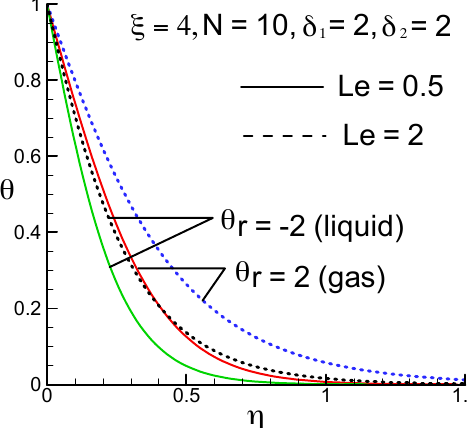
Figure 2. The dimensionless temperature profile for two values of Le and θ r .